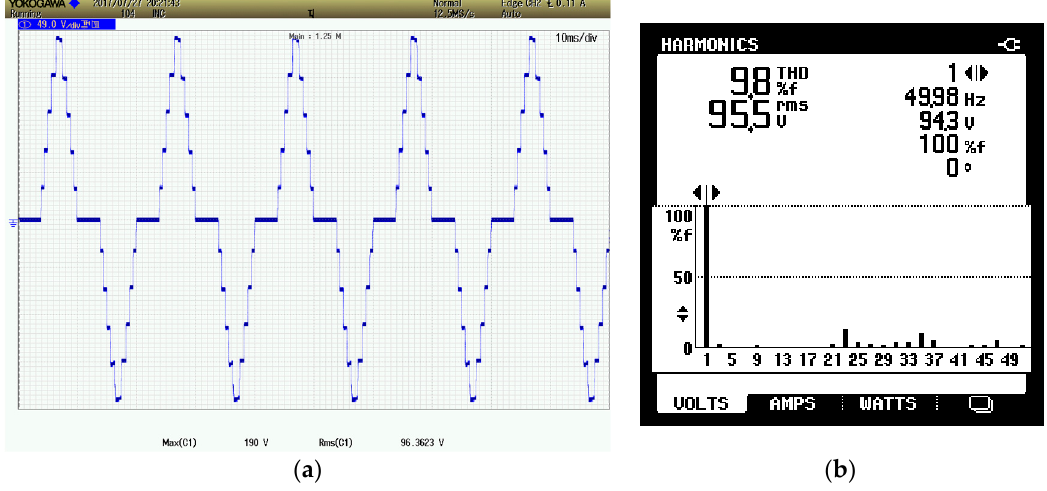
Figure 11. Experimental results for pattern ‘ a ’ ( a ) output voltage waveform at M = 0.432; ( b ) FFT spectrum.